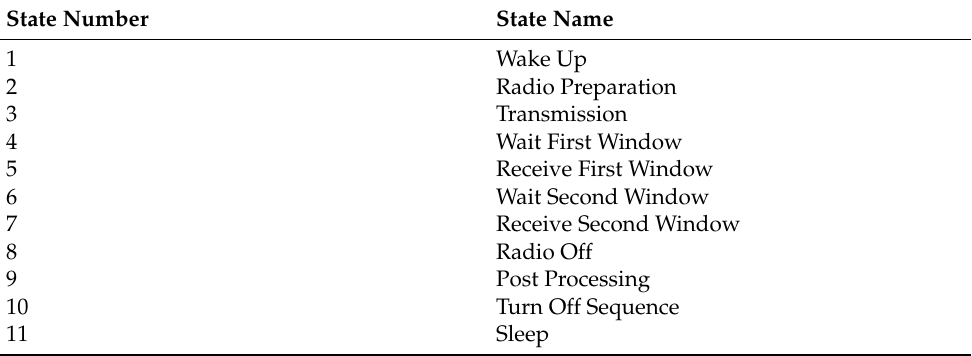
Table 6. Casals et al. LoRaWAN Transmission States